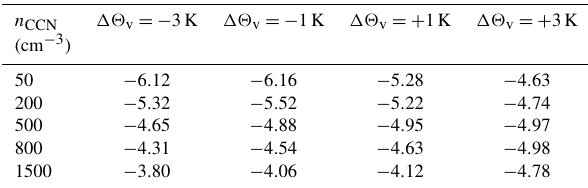
Table A8. Temperature sensitivity (in %K − 1 ) of the drying ratio DR for all n CCN